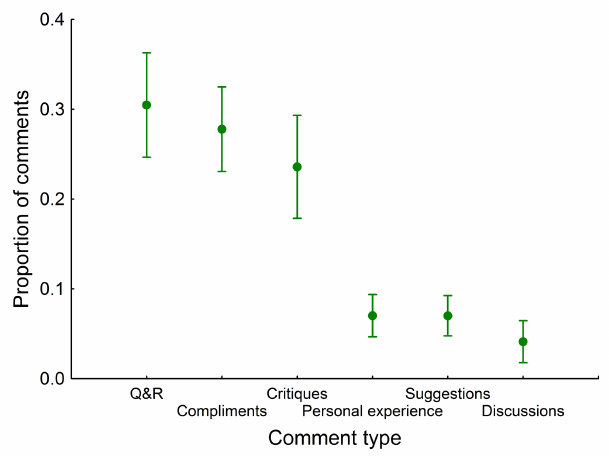
Fig. 7 . Comparison of the means of proportions of comments in favor of hunting activity. Q&R = Questions for or requests to the uploader.